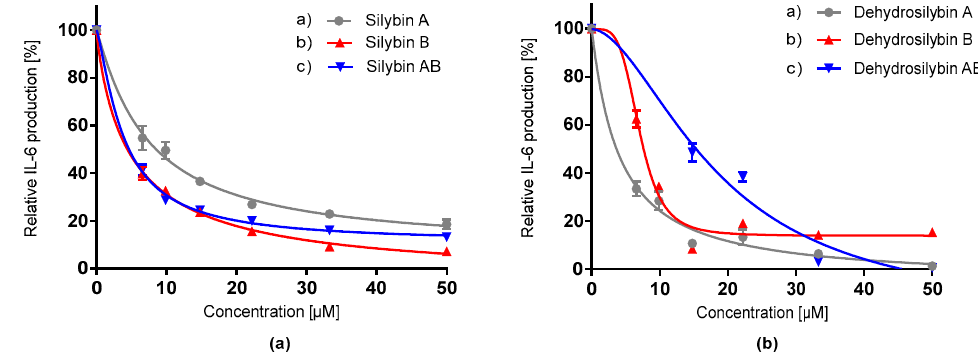
Figure 6. E ff ect of silybin diastereomers ( a ) and dehydrosilybin enantiomers ( b ) on relative production of IL-6 by LPS-stimulated RAW 265.4 macrophages. Data represent the average of four repetitions with corresponding standard error of the mean. Table 5. The e ff ect of various concentrations of silybins and dehydrosilybins (12.5, 25, 50 µ M) on the release of pro-inflammatory cytokine IL-6 by LPS-induced macrophages. Positive control represents the cells challenged with LPS without the presence of tested compounds. IL-6 (pg /